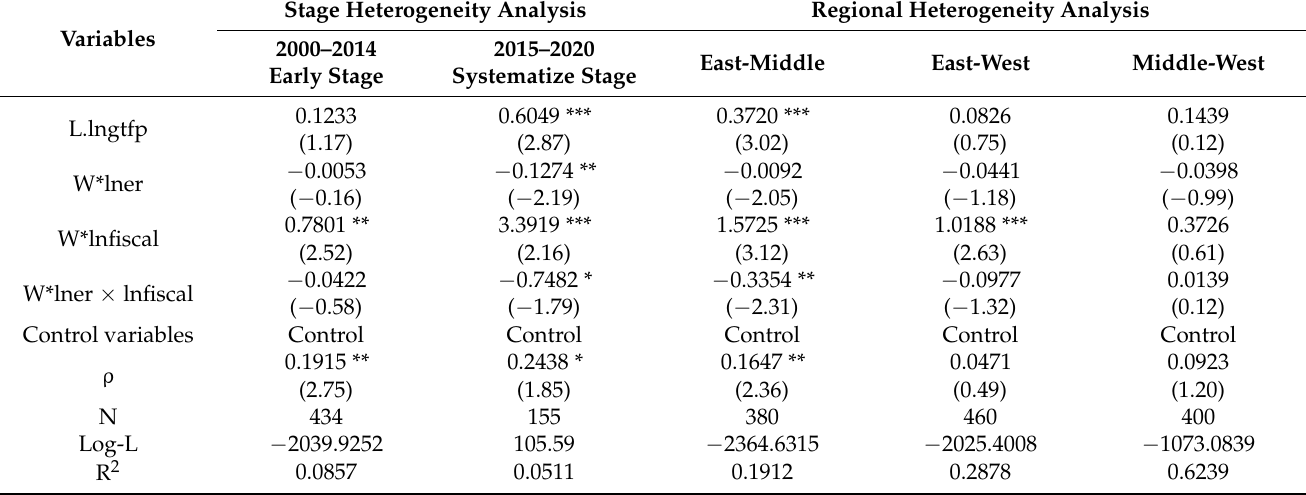
Table 6. Analysis of